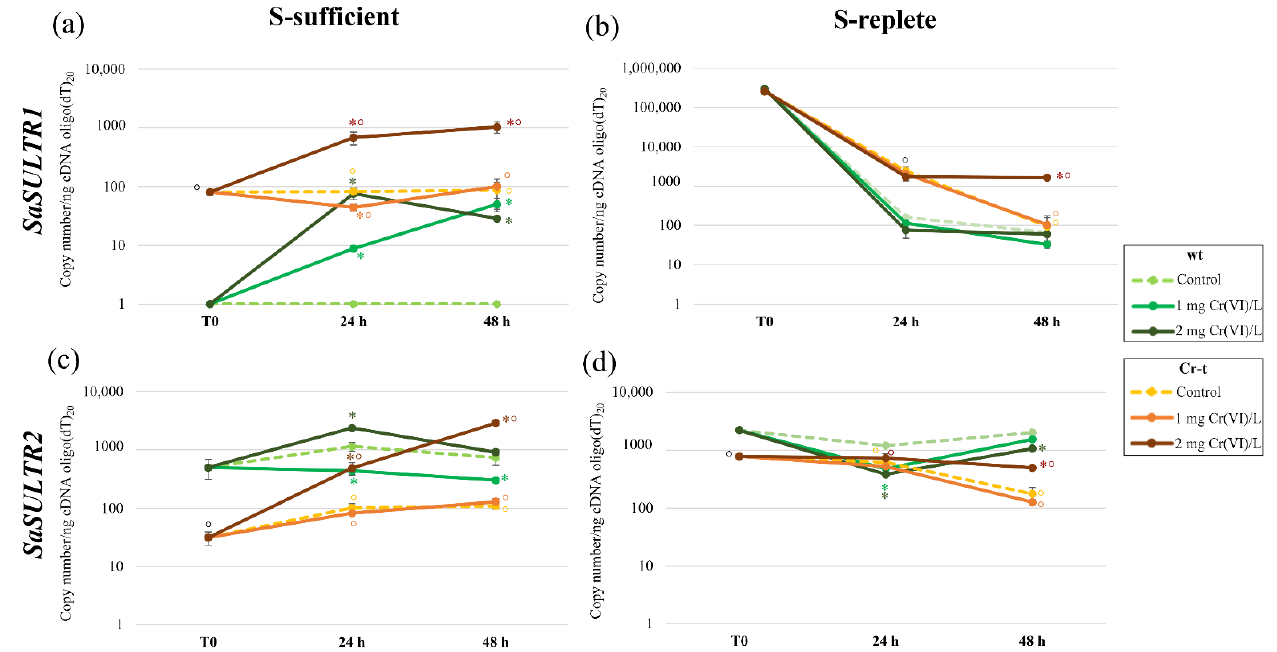
Figure 10. aqPCR of SaSULTR1 ( a , b ) and SaSULTR2 ( c , d ) in both S-sufficient and S-replete condition. Statistical analysis was performed using one-way ANOVA with the Tukey post hoc test ( p < 0.05) after the Shapiro-Wilk normality test. *: significant difference between Cr-treated (with 1 or 2 mg Cr(VI)/L) and untreated cells within strain. °: significant difference between the two strains in similar conditions.